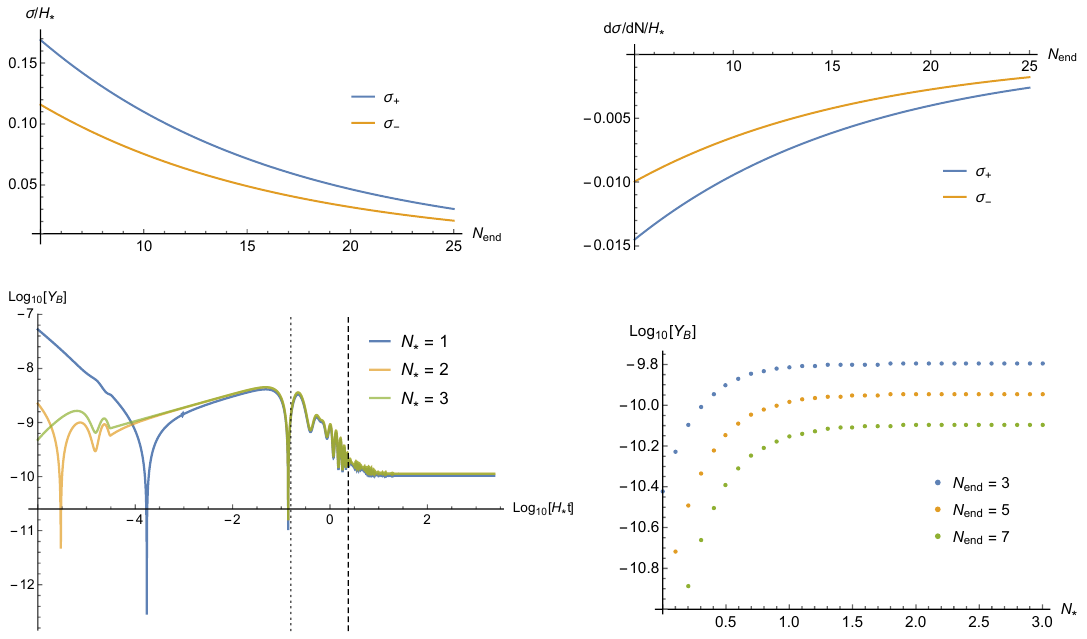
Figure 5 . The baryon asymmetry | Y B | generated by a heavy AD field m σ = H ∗ / 2 with tachyonic initial masses led by the choice of { c = {− 2 , 1 , 1 } . Upper panel: initial conditions of the 1 , c 2 , c 3 } mass eigenstates (left) and their time derivatives (right) with respect to N . Lower left panel: the end time evolution of | Y from the end of inflation to reheating complete with respect to various choices B | of N and N = 5 . The vertical dotted line is t = π/m and the vertical dashed line is t = 1 / Γ . ∗ end I I Lower right panel: the final | Y in radiation domination with respect to various choices of N . In B | end all panels, Λ = M , H = 2 . 37 × 10 13 GeV and Γ = 10 13 GeV are P ∗ I